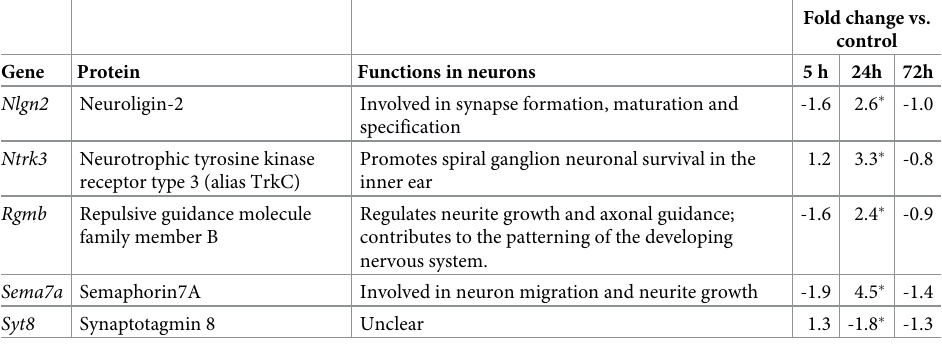
Table 1. Five neuronal regeneration-related genes with significant changes in the spiral ganglion after kainate treatment.